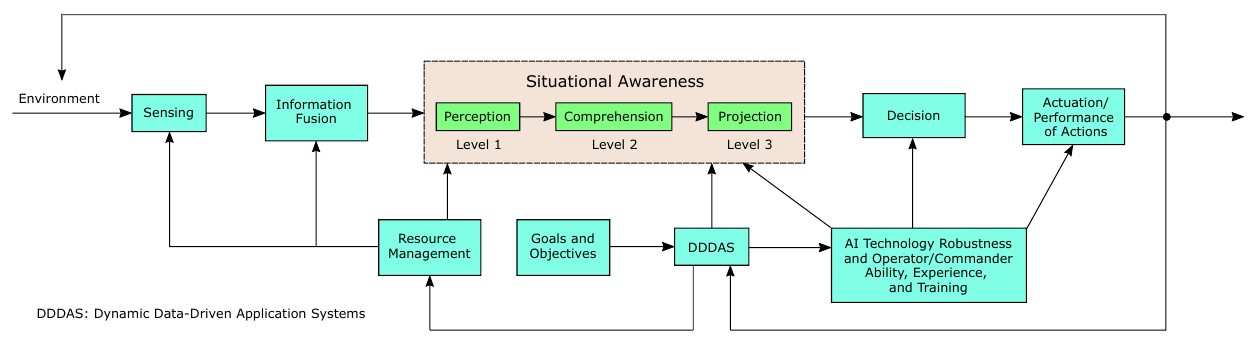
Figure 2. Model of SA and dynamic